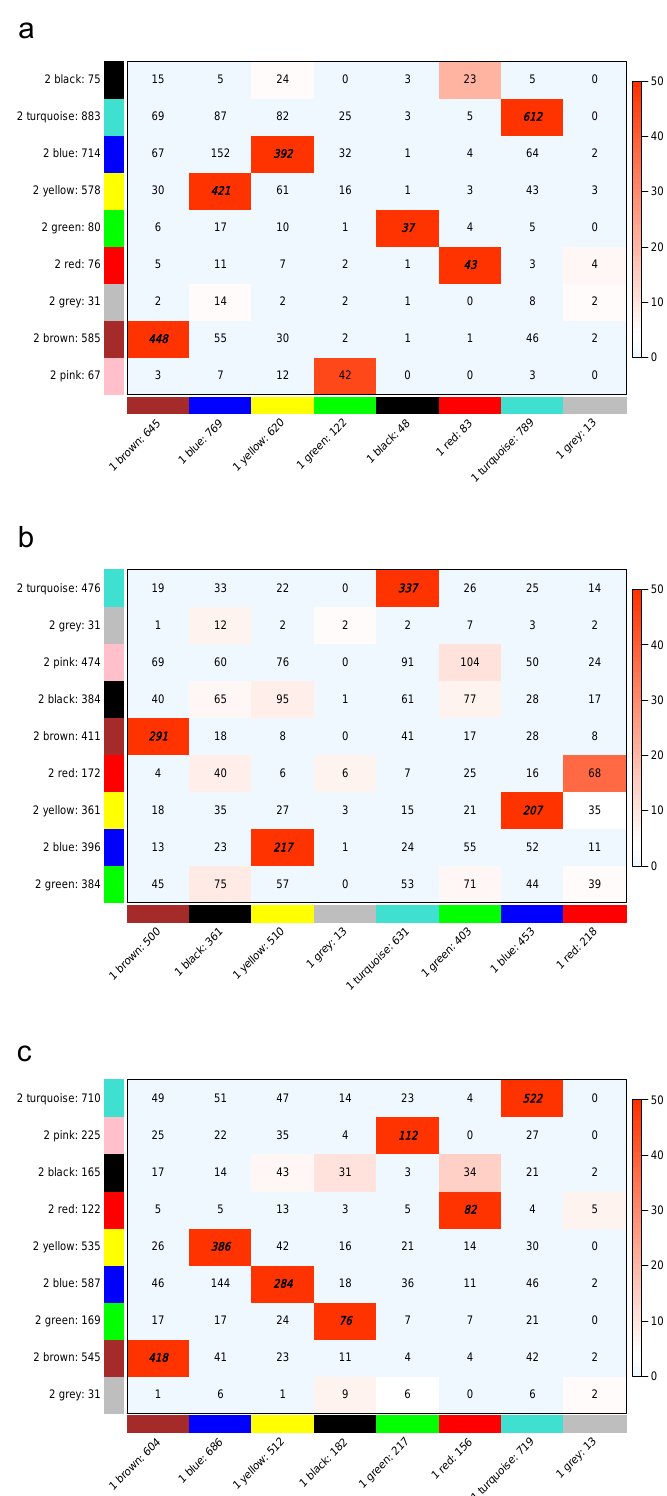
Figure 5. Module preservation between even partitioning of the liver dataset for WGCNA ( a ), k- eigengene ( b ) and k-module ( c ). All cells with a color depth below − log 10 ( 0.05 ) are shown as light blue, while the other cells maintain a color gradient from white to red. The modules with preservation significance greater than 50 have the numbers printed in bold and italic. The k-module algorithm has reasonable module preservation